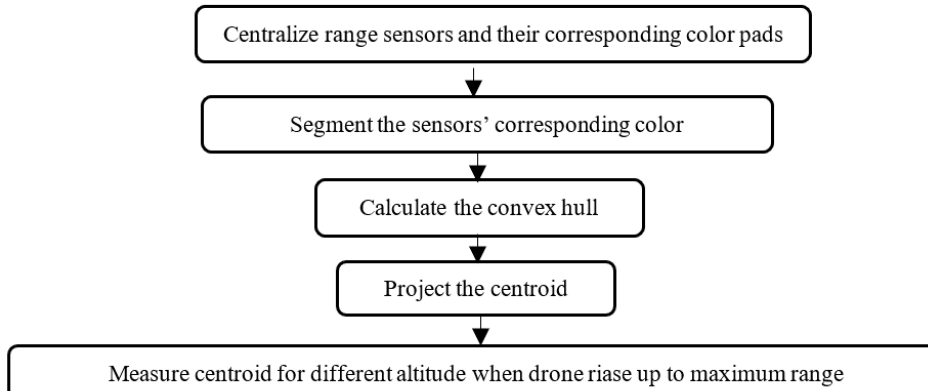
Figure 4. Camera range calibration procedures in each stage.